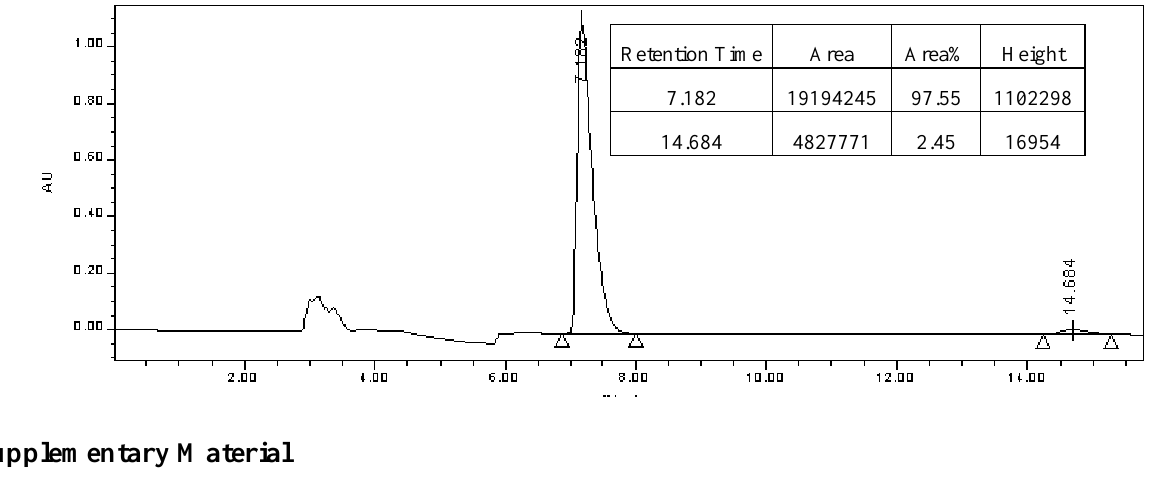
Figure 4. Resolution of methyl mandelate with OD-H chiral stationary